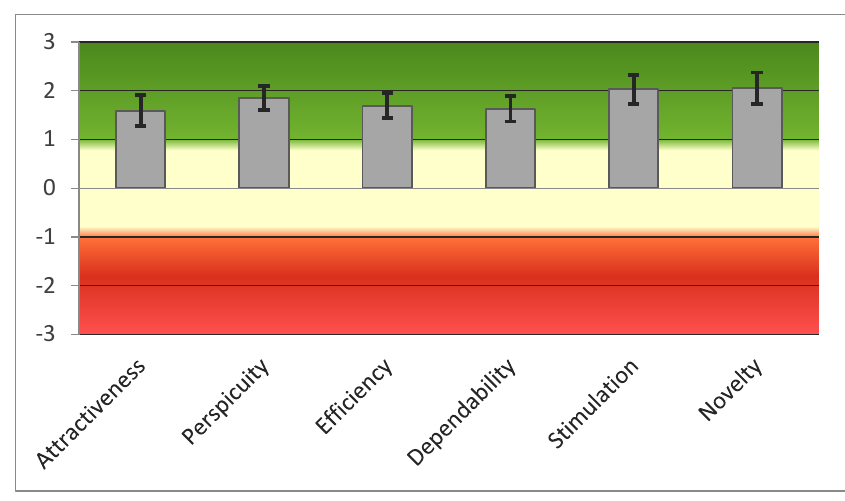
Figure 8. Graphic representation of scores of the six UEQ scales.